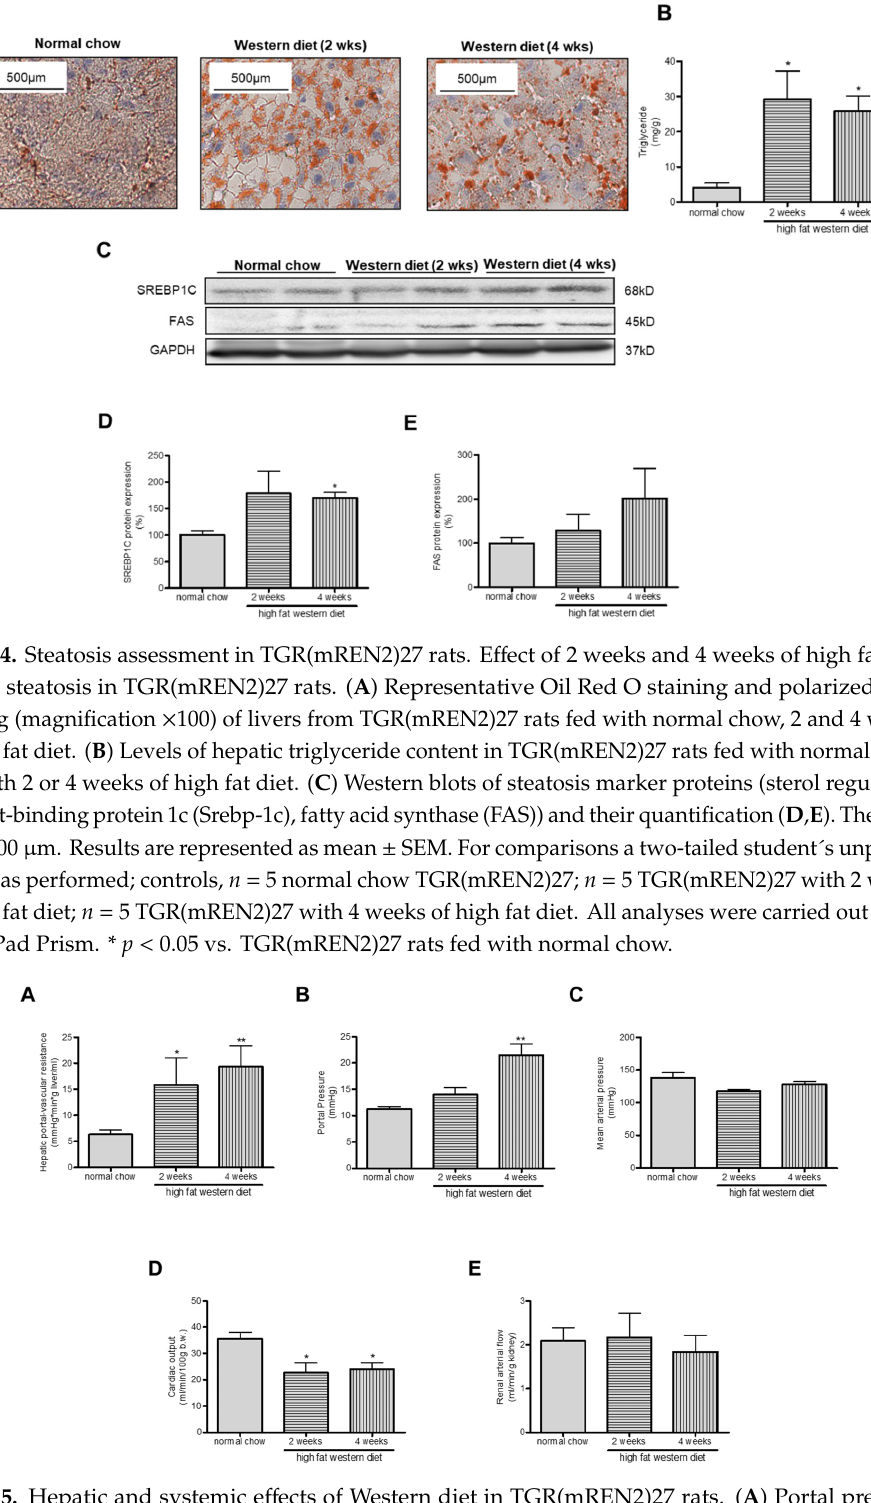
Figure 5. Hepatic and systemic effects of Western diet in TGR(mREN2)27 rats. ( A ) Portal pressure is increased after two and four weeks of WD. ( B ) Hepatic portal-vascular resistance increases after WD. ( C ) Mean arterial pressure shows no relevant alteration after WD feeding. ( D ) Cardiac output is reduced in rats receiving WD. ( E ) The renal arterial flow in TGR(mREN2)27 rats was investigated using the colored microsphere technique. Columns illustrate the renal arterial flow in ml/min/g kidney of rats. */** p < 0.05/0.01 vs. normal chow. Table 2. Hemodynamics in transgenic TGR(mREN2)27 rats with normal chow vs. 2 and 4 weeks of Western diet.